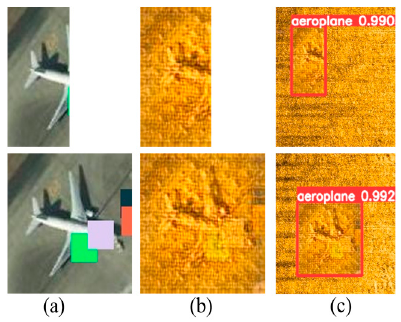
Figure 16. Detection result on validation data. ( a ) Simulated incomplete target. ( b ) Style transfer target. ( c ) Detection result in sonar background. Table 8. Detection confidence on 4 types of noises (test in validation data).